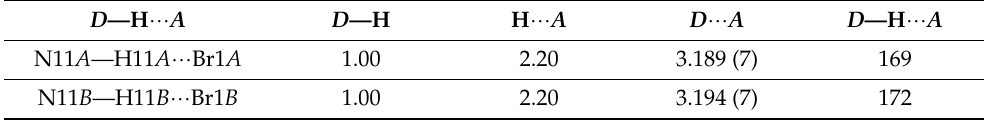
Figure 17. The intermolecular hydrogen bonds in compound 7 . Table 7. Strong hydrogen-bond geometry (Å, º) for 6 .